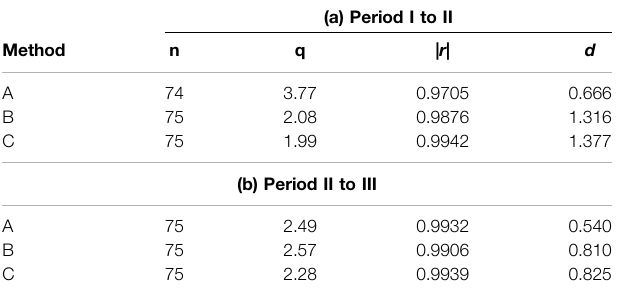
TABLE8| Comparisonofoptimal fi ttingparametersintherankdependenceofthe intersecting angle of the monthly precipitations on the Japanese stations. (a) FromPeriodI(from1931to1960)toPeriodII(from1951to1980);(b)FromPeriod II (from 1951 to 1980) to Period III (from 1981 to